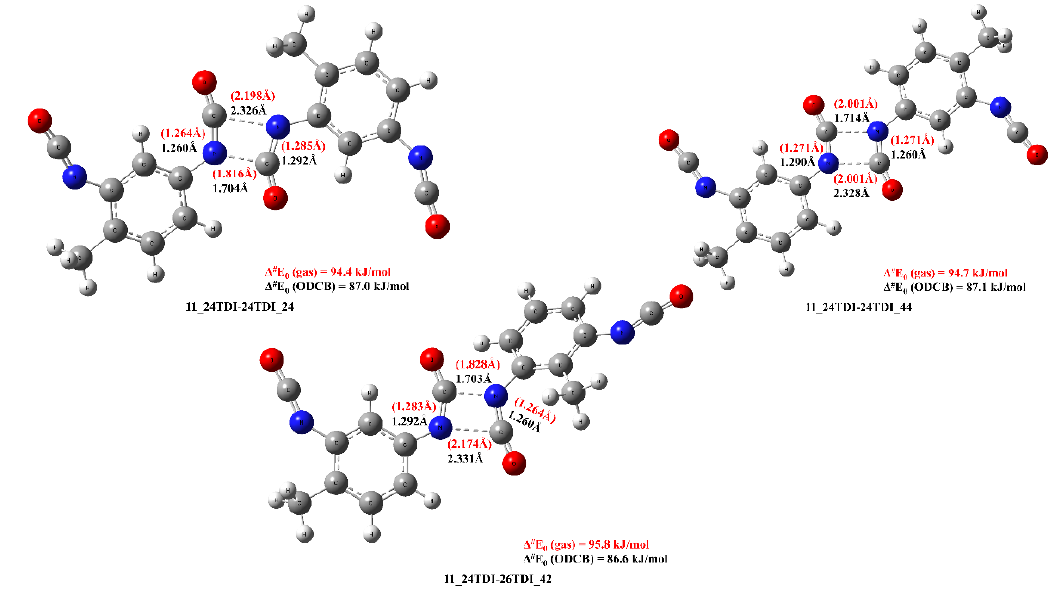
Figure 3. The low-lying transition state structures of TDI dimerization in the gas phase (in red) and in ODCB (in black) obtained at the B3LYP/6-31G(d) level of theory.